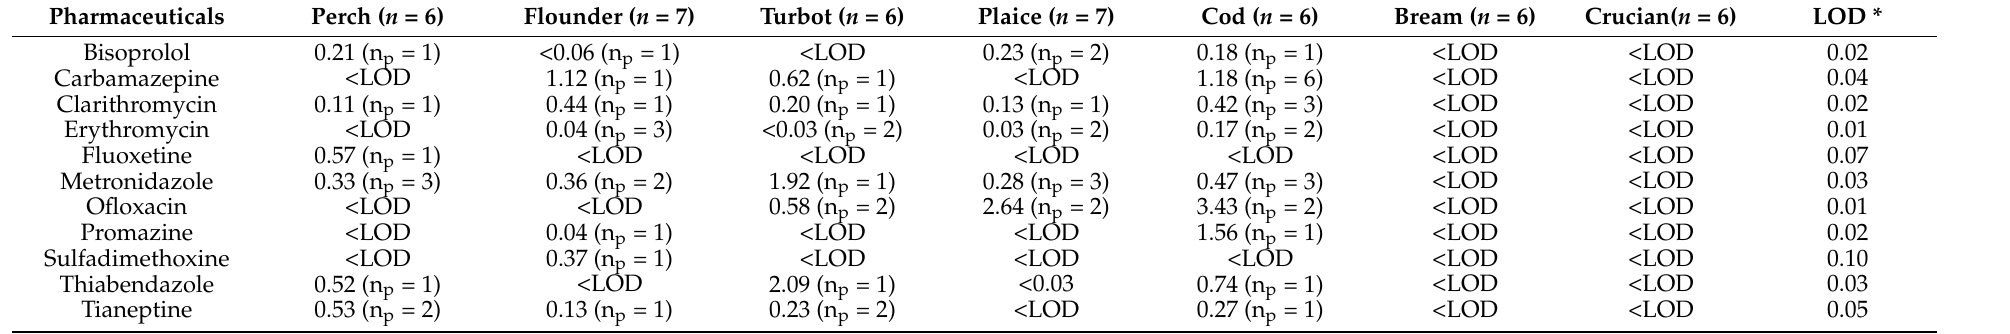
Table 1. The maximum concentration of pharmaceuticals detected in fish muscles (ng/g) and the number of positive findings (n p ).